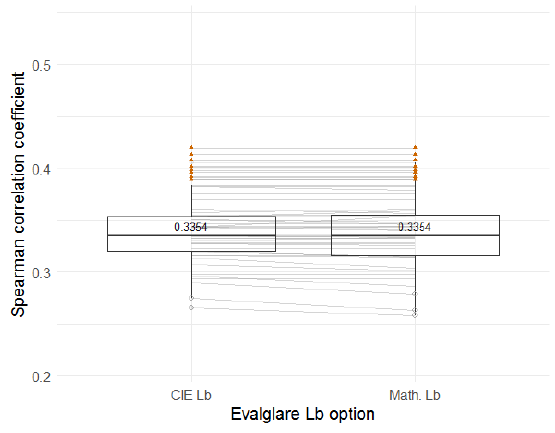
Figure 12. Boxplots of Spearman rho for the two background luminance definitions (field study).